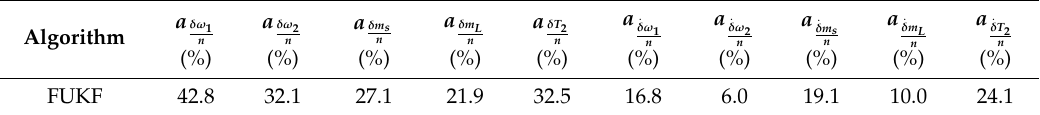
Table 3. Values of the percentage di ff erences of the estimation errors and their derivatives for the FUKF in relation to the UKF—simulation study.